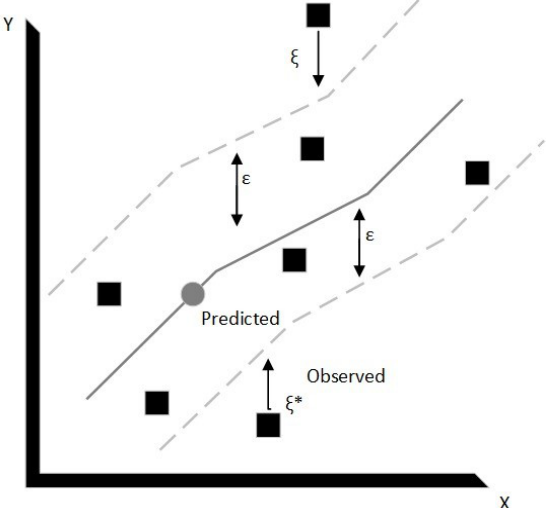
Figure 2. Visualization of Support Vector Regression (SVR) parameters (regenerated based on